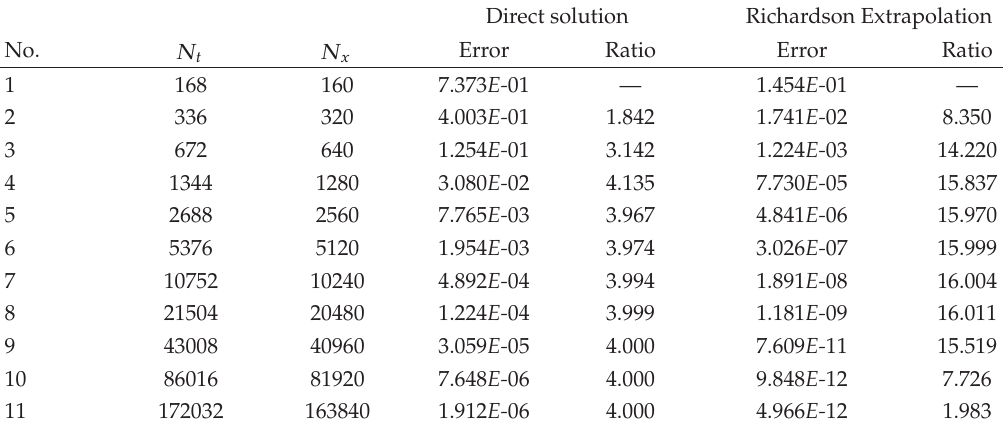
Table 1: Results obtained when the test problem defined by (cid:6) 5.3 (cid:7) – (cid:6) 5.5 (cid:7) is handled directly by the Crank- Nicolson scheme and by using the combination of the Crank-Nicolson scheme and the Richardson Extrapolation. The numerical errors calculated by (cid:6) 5.1 (cid:7) and (cid:6) 5.2 (cid:7) are given in the columns under “Error”. In row s, s (cid:3) 2 , 3 ,..., 11, the ratios of the errors in this row and in the previous row are given in the columns under “Ratio”. Direct solution Richardson